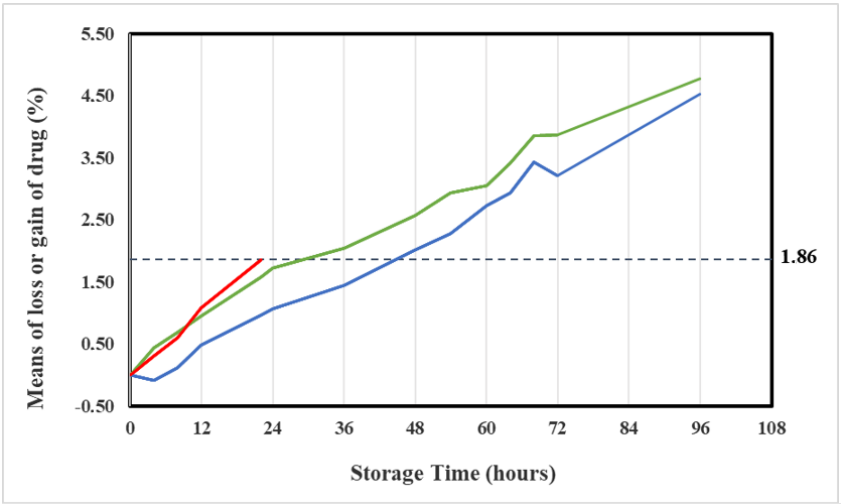
Figure 6. Trend of the mean percentage of azacitidine lost in the original container over 22 h (red line), in a polypropylene syringe (green line), and in a polypropylene syringe placed between two refrigerant gel packs (blue line) over 96 h. The dotted line represents the maximum 1.86% loss (relative to the initial experimental concentration) identified as the maximum acceptable change of concentration.